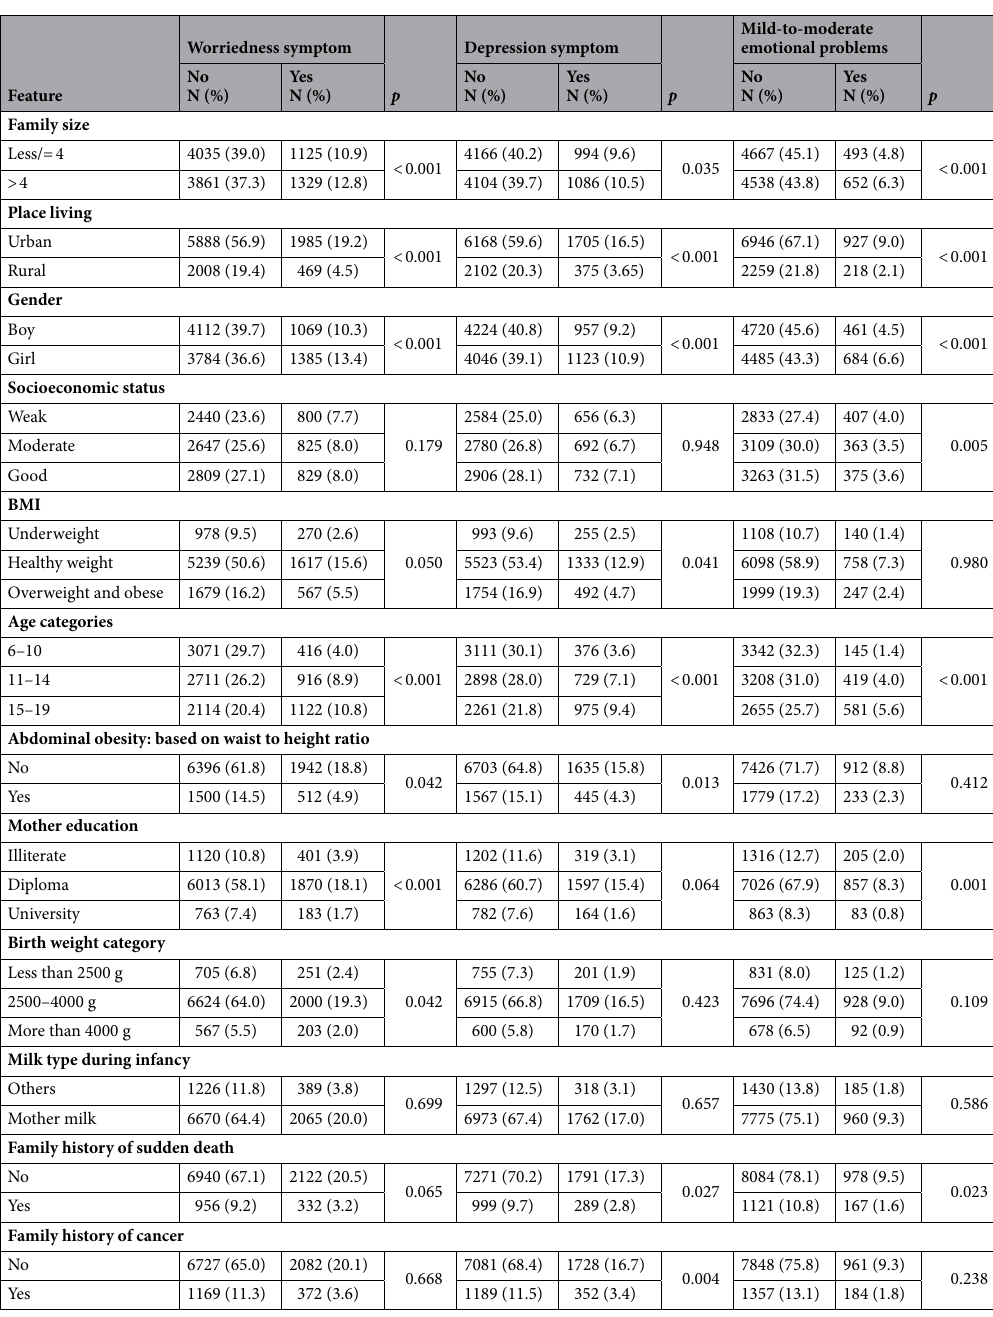
Table 1. Demographic and socioeconomic characteristics of participants: the CASPIAN-IV study. N number of people who are in each